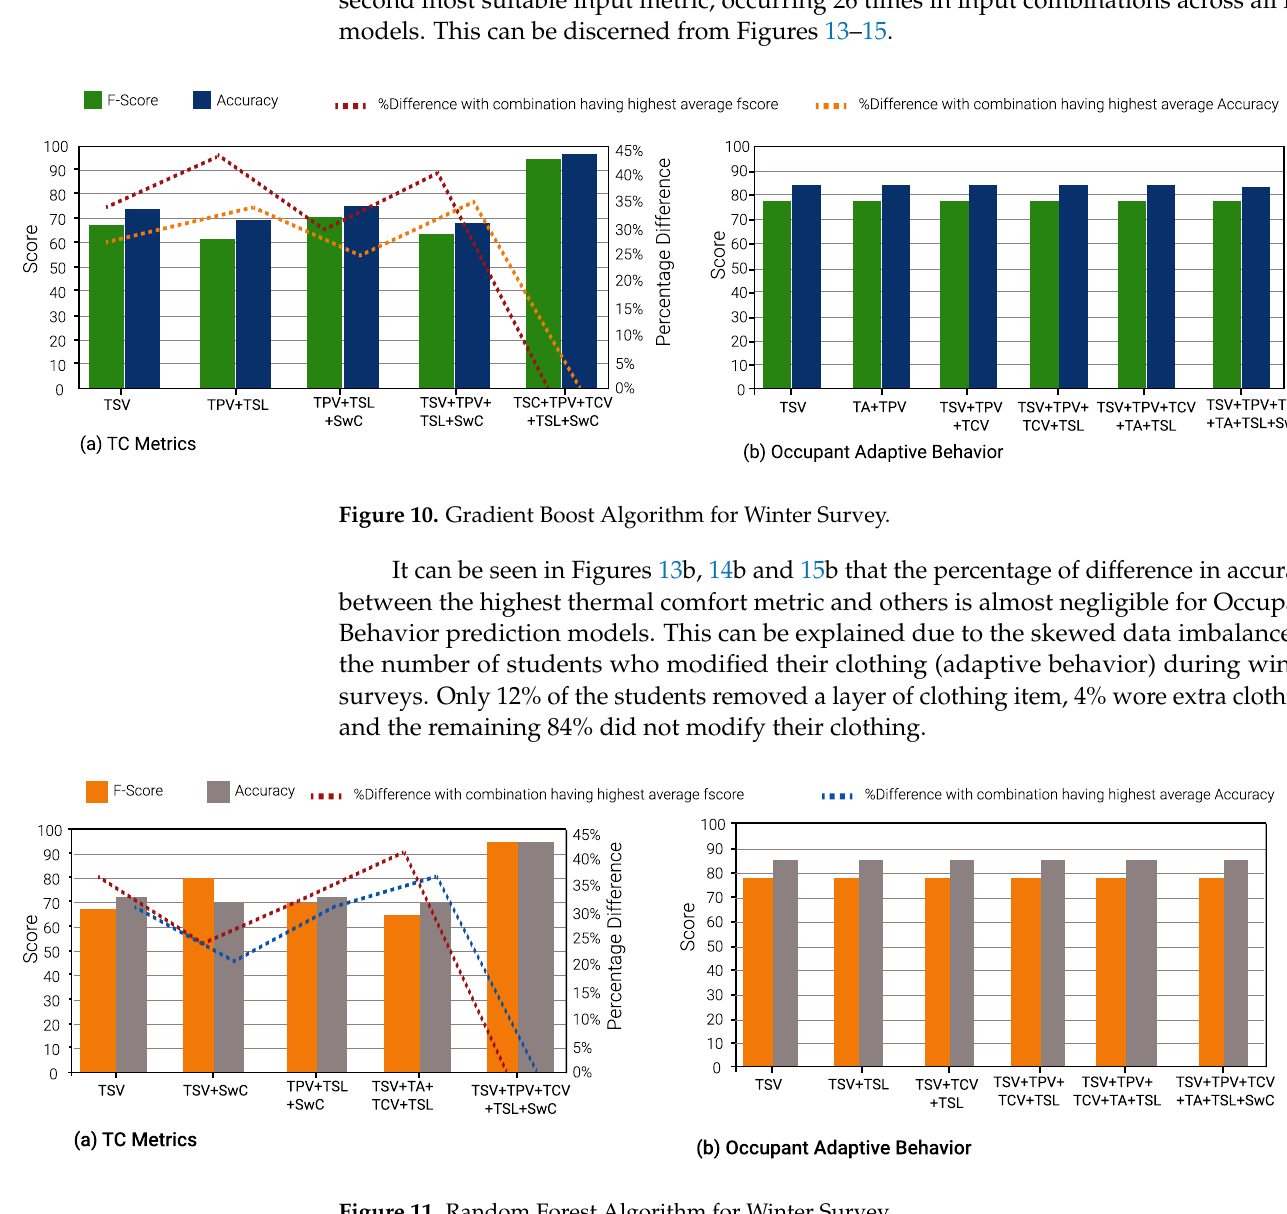
Figure 11. Random Forest Algorithm for Winter